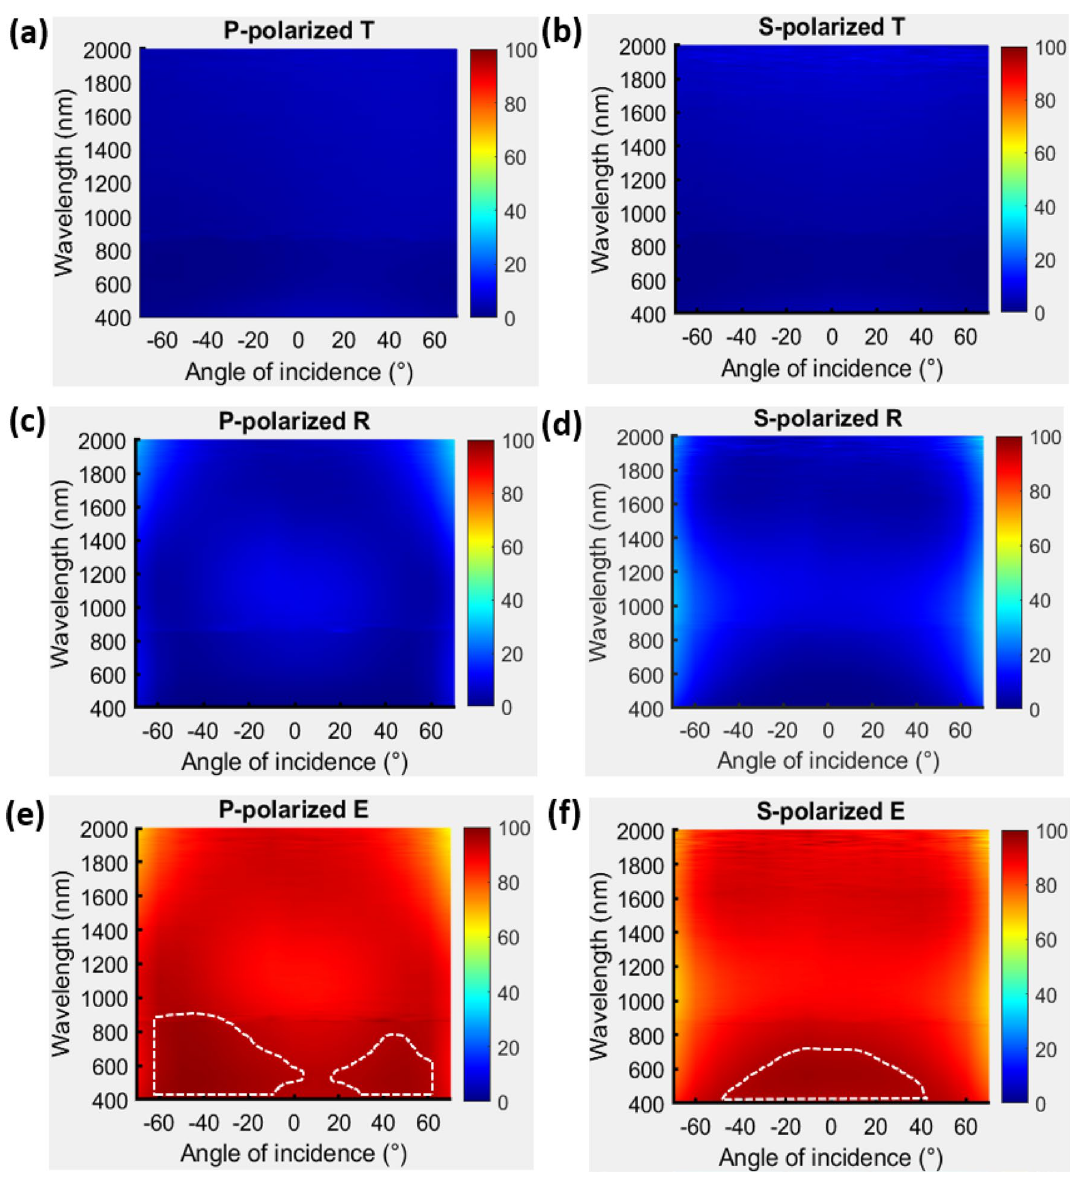
Figure 6. P-polarized and s-polarized transmittance ( a , b ), reflectance ( c , d ), and extinctance ( e , f ) rods, as shown in Fig. 8. The strong electric filed distributed inside each rod indicates the resonance of transverse plasmonic mode 26 . For s-polarization (the electric field is oscillating along the x-axis), the cross-sectional x–z and y–z planes shows that the upper rods have stronger field enhancement than the bottom rods, as shown in Fig. 9. The strong electric filed distributed between rods indicates the resonance of longitudinal plasmonic mode 26 . Since the permittivity of the TiN film is negative and its magnitude increases with wavelength, the optical property of the TiN film is similar to noble metals at infrared wavelengths. Therefore, the enhanced field intensities at wave- lengths of 1000 nm and 1500 nm are stronger than those at 400 nm and 600 nm. The metal-like optical property of TiN NRA would enhance longitudinal plasmonic resonance and lead to increase in reflection. Therefore, the extinction at visible wavelengths is larger than that at infrared wavelengths. In summary, a broadband absorber was designed, fabricated and optically characterized. The admittance matching of an obliquely deposited TiN nanorod array reveals that the localized plasmon resonance exhibits absorption only in the far field. By varying the orientation of a TiN nanorod array with respect to the incident polarized light, the absorption spectrum can be varied to fulfill certain demand. Since TiN is a refractory material,